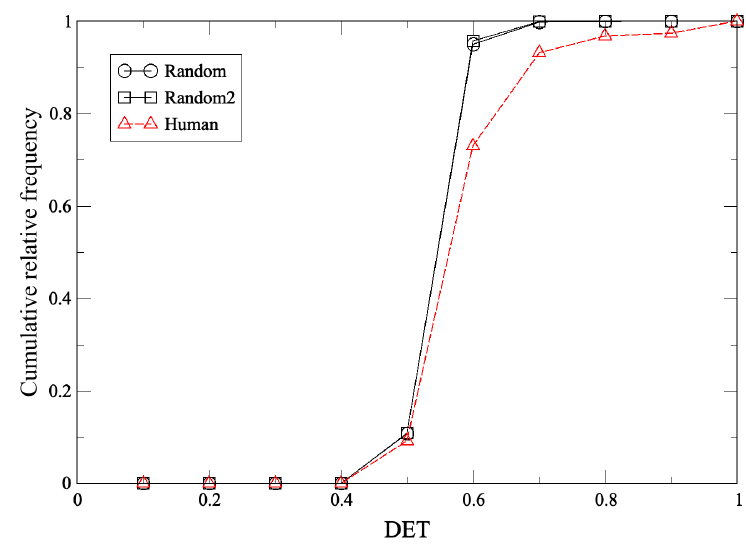
Figure 3. Cumulative relative frequency distribution of DET from recurrence plot obtained from the set of human RPS time series and pseudorandom series. Here, “Random” and “Random2” show the results from the sets of 500 and 10 8 pseudorandom series generated using the Mersenne Twister, respectively. As shown in Figure 4, the results from the pseudorandom series follow a normal distribution.